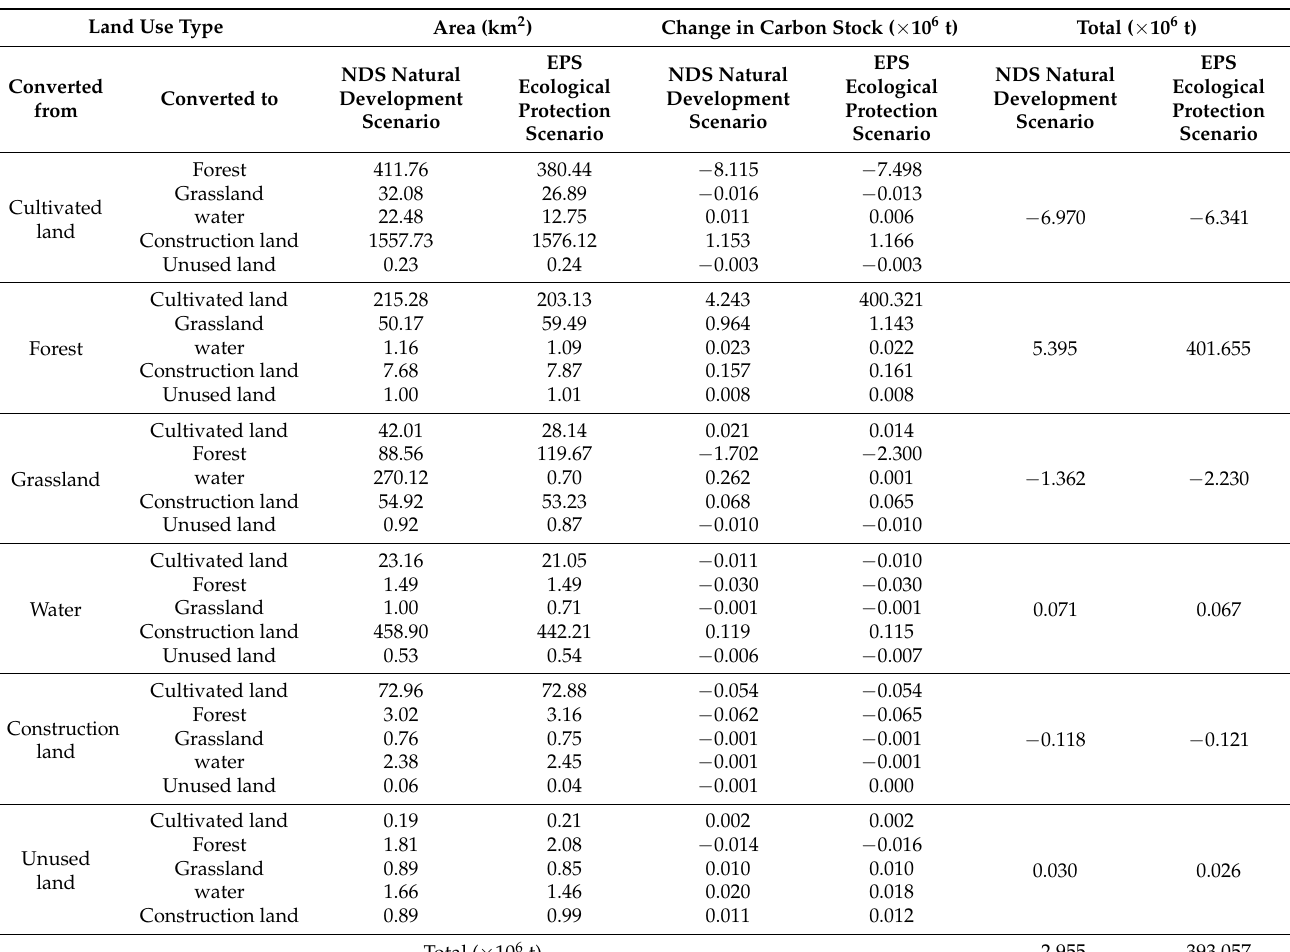
Table 7. Under scenarios of natural progression and ecological protection in 2020–2030, land type conversion will influence the amount of carbon stored in the